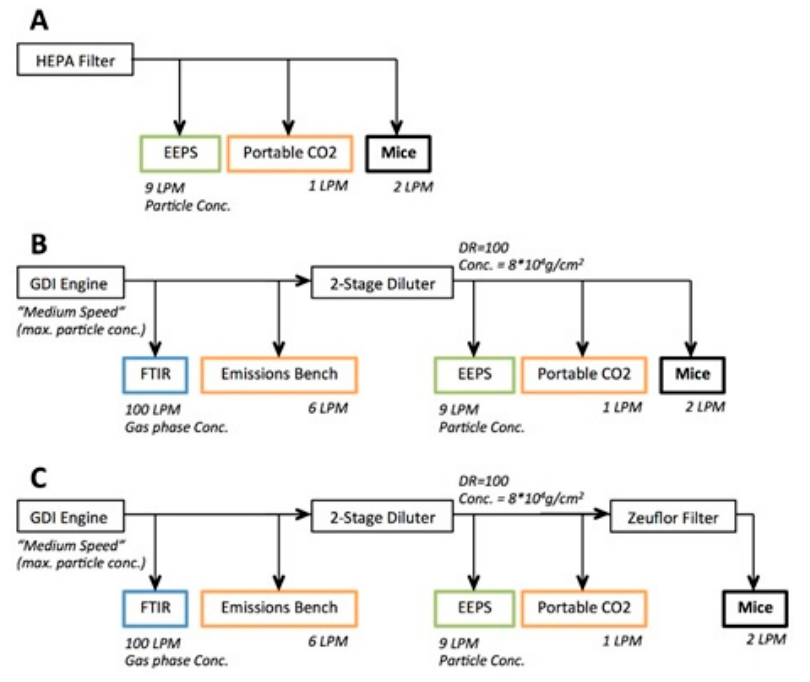
Figure 1. Overview of GDI engine exhaust sampling and exposure system: HEPA filtered ambient air ( A ); GDI engine exhaust ( B ); and GDI engine exhaust filtered with the Zefluor filter filtered GDI ( C ). An isotopically-labelled internal standard mixture was used to spike filters before extraction.